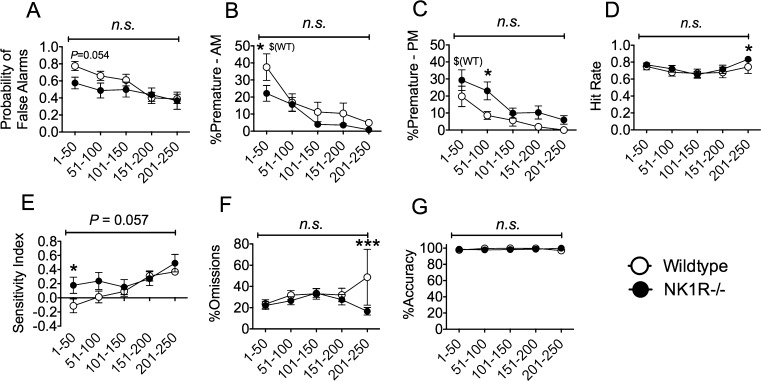
Changes in the performance of NK1R−/− mice and their wildtypes during the extended test session (NI-1) of the 5C-CPT. Circles show mean ± s.e.m. Numbers on the abscissae indicate bins of trials within NI-1. Although the performance of the two genotypes changed during NI-1, there was no overall genotype difference for any behavioural measure. With the exception of the Probability of False Alarms and %Accuracy, post hoc comparisons of pairs of data revealed differences between the two genotypes but in one trial-bin, only. *P < 0.05; ***P < 0.001; (Genotype comparison) $P < 0.05 (Time-of-Day comparison (AM versus PM)).